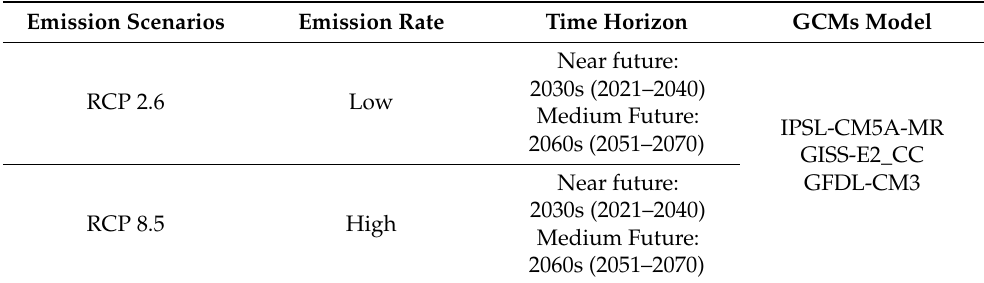
Table 2. The climate change scenarios and GCMs used in this study for future projection.